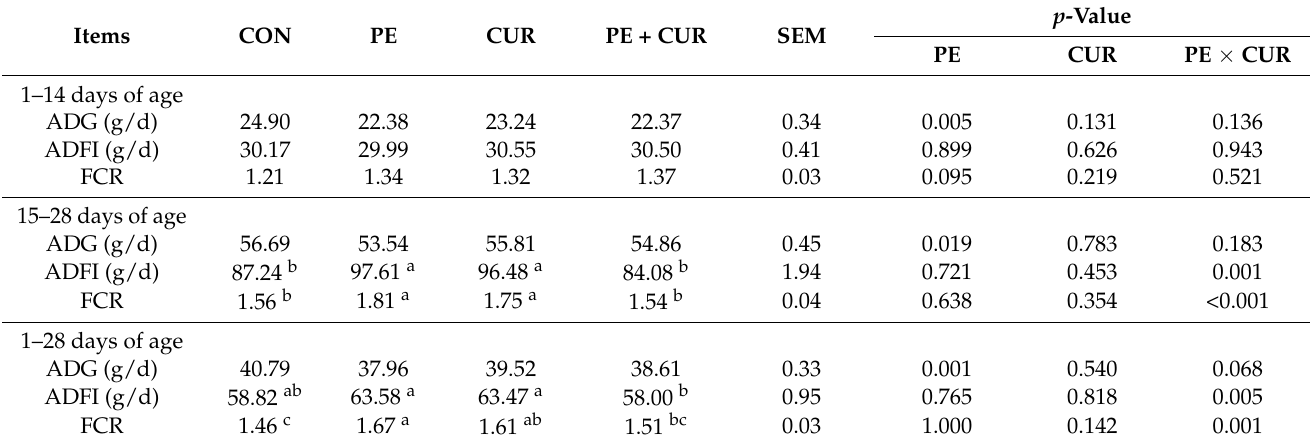
Table 3. Effects of dietary supplementation with PE and CUR on growth performance of broilers 1